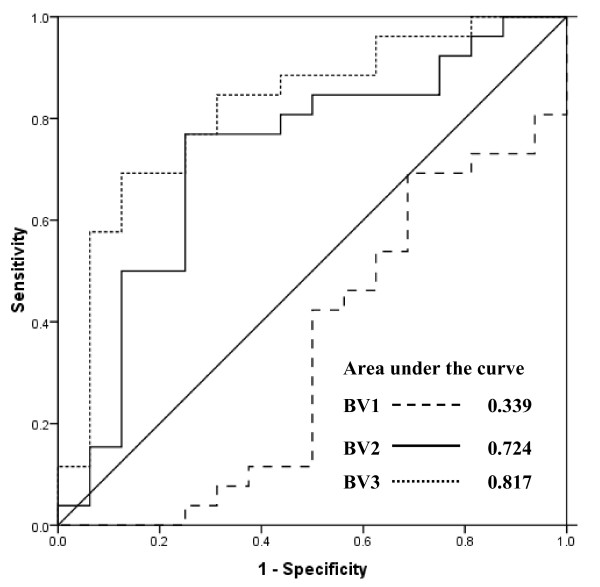
Receiver-operating characteristics (ROC) curves for an early estimation of response to therapy by plasma VEGF levels available before the start of therapy cycle 1 (BV1), cycle 2 (BV2), and cycle 3 (BV3).